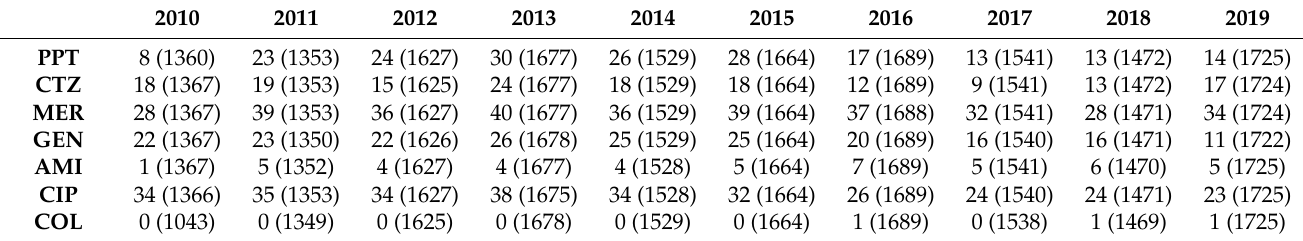
Table 5. Resistance of Pseudomonas aeruginosa to antibiotics at the University Hospital Olomouc in 2010–2019. 2010